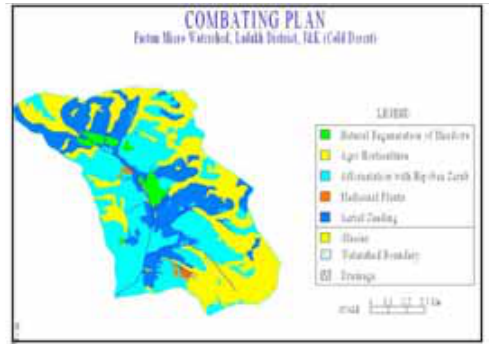
Fig. 5: Desertification combating plan